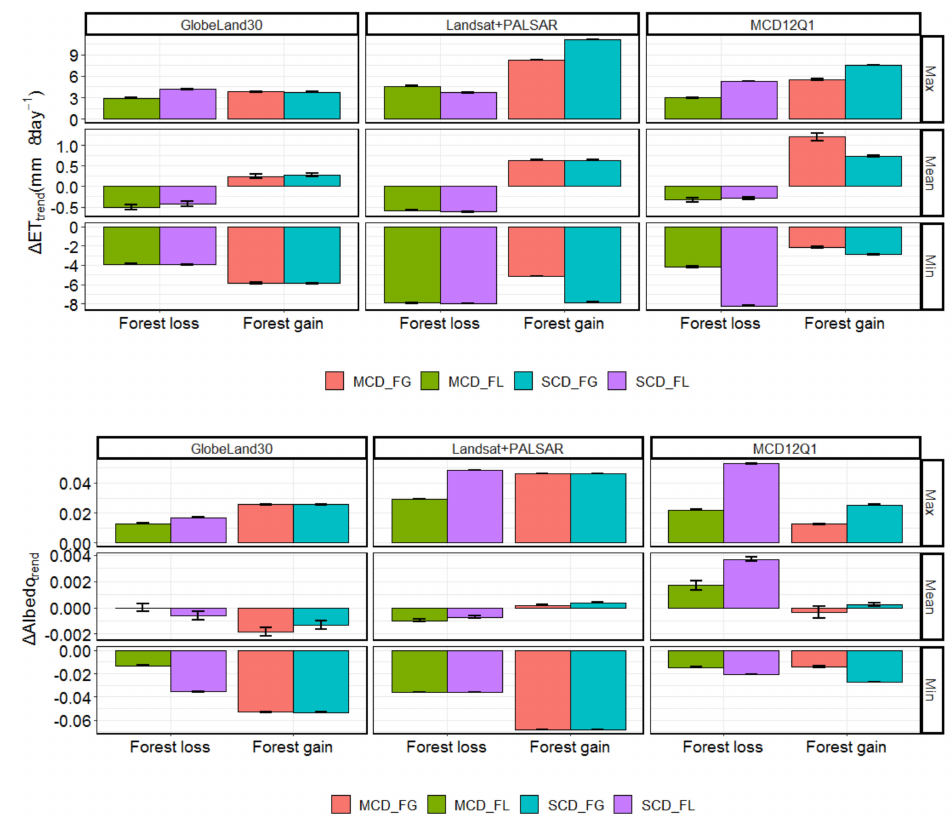
Figure 9. Annual ET and albedo di ff erences caused by the three dataset-based forest losses and gains estimated by MCD and adjusted SCD from 2000–2010. The vertical lines on each bar represent the confidence interval at 95% estimated by t